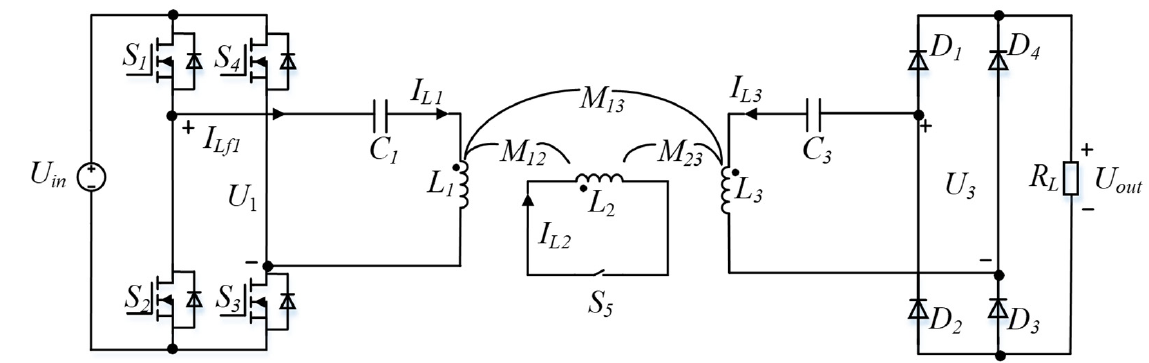
Figure 10. Proposed circuit of the WPT system.